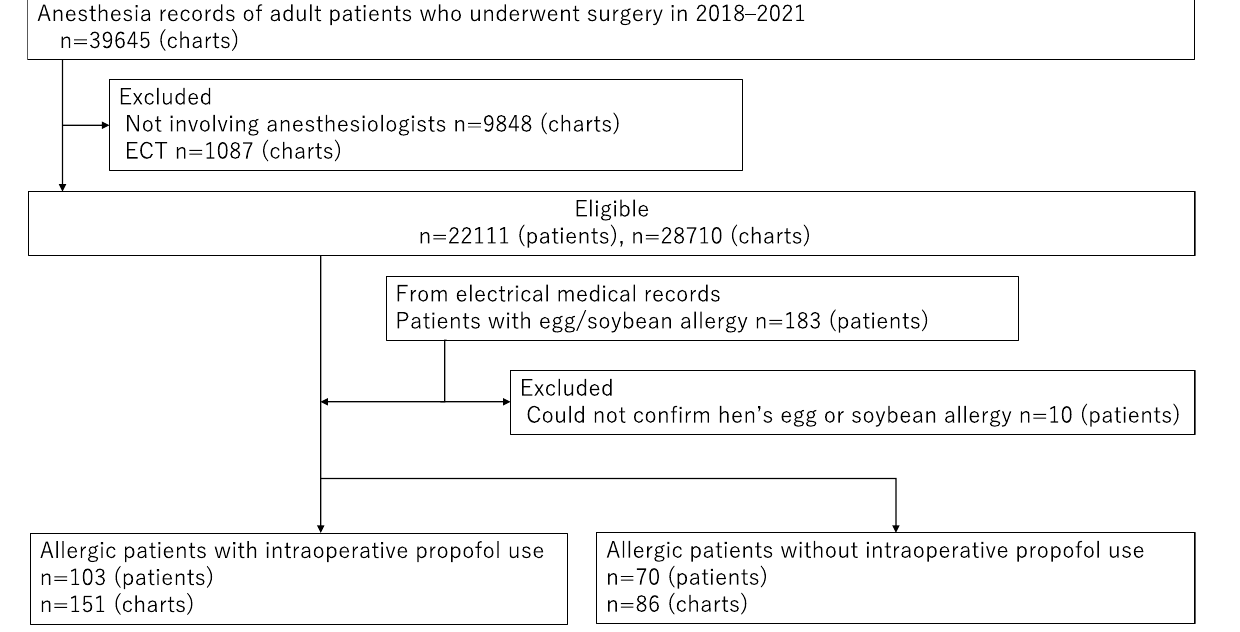
Fig. 1 Flowchart of the study. ECT, electroconvulsive therapy